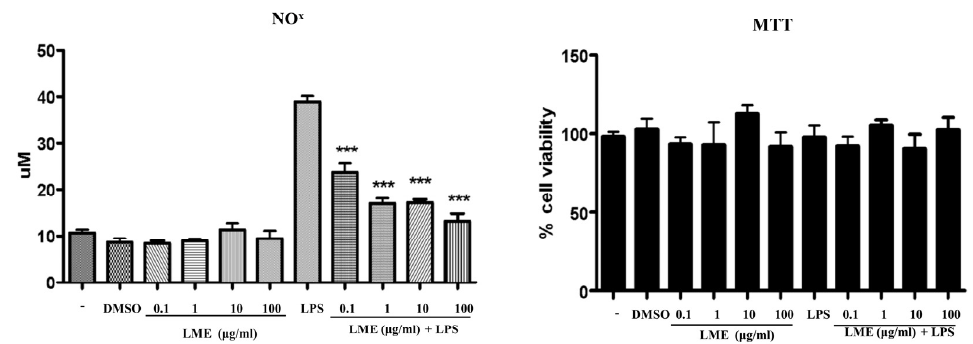
Figure 3. Effects of LME (0.1–100 µ g/mL) on nitrite accumulation and cell viability in RAW 264 cells. Data are expressed as means ± SEM. The experiments were performed three times. *** p < 0.001 vs. LPS-stimulated cells.